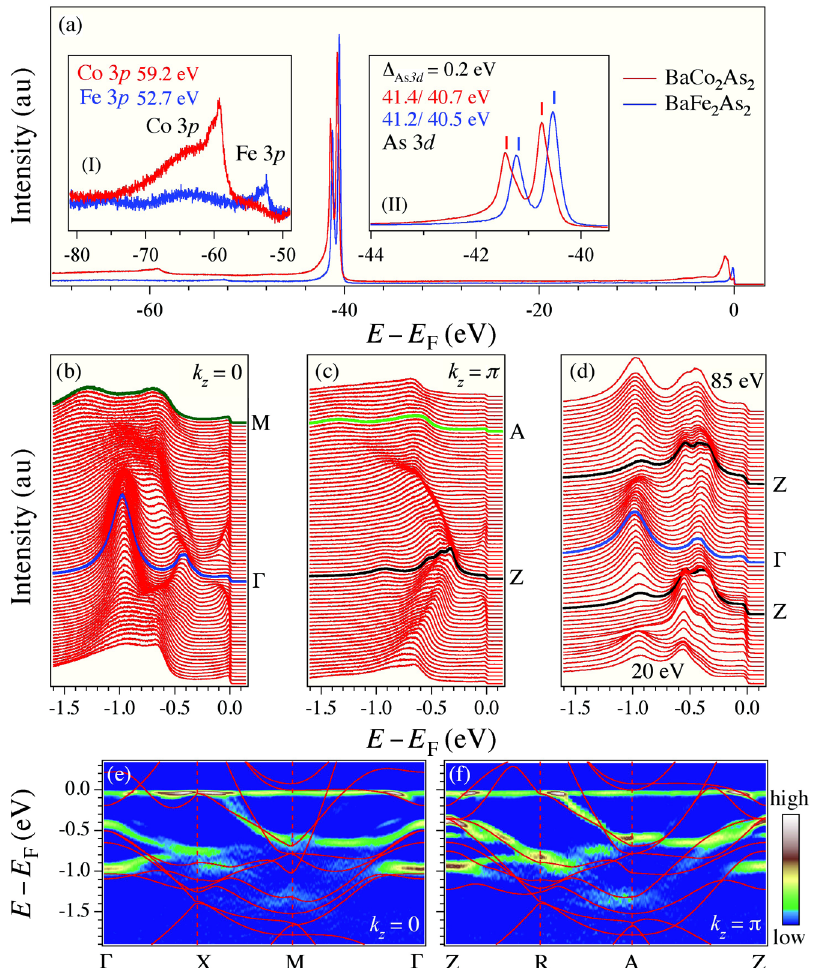
FIG. 1. (a) Core level spectra of BaCo 2 As 2 (red) and BaFe 2 As 2 (blue) recorded with 195-eV photons. Insets I and II are close-ups of the Fe ð Co Þ 3 p and As 4 d levels, respectively. (b),(c) EDCs measured at 20 K along (cid:1) -M ( k z ¼ 0 ) and Z-A ( k z ¼ (cid:1) ), respectively. (d) Photon-energy dependence of the EDCs taken at the BZ center. (e),(f) 2D curvature-intensity plots [17] along high-symmetry lines in the k z ¼ 0 and k z ¼ (cid:1) planes, respectively. Nonrenormalized LDA bands are overlapped for